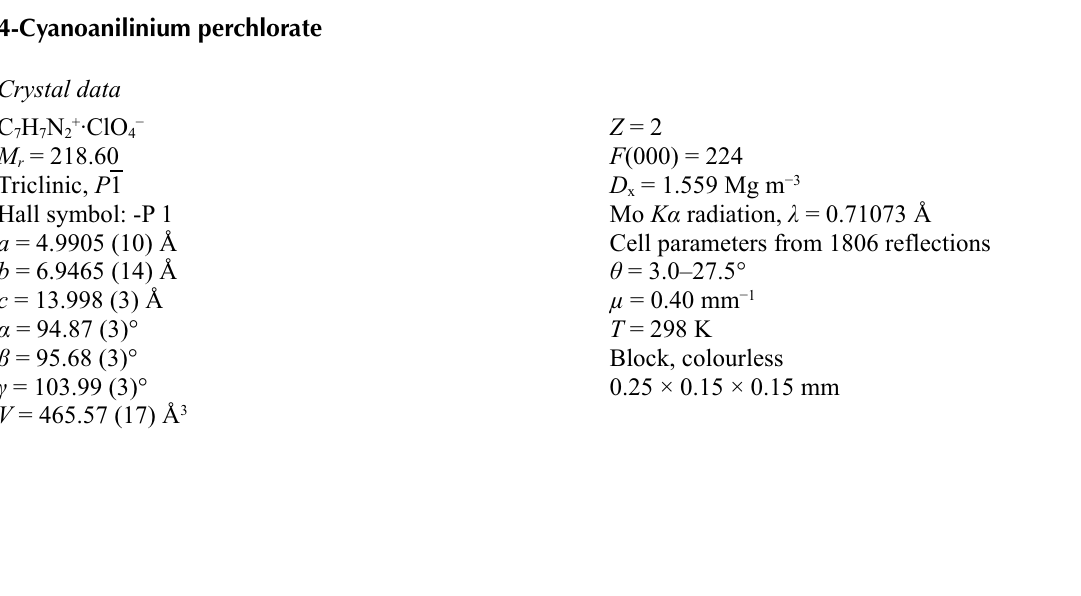
The crystal packing of the title compound viewed along the b axis and all hydrogen atoms not involved in hydrogen bonding (dashed lines) were omitted for